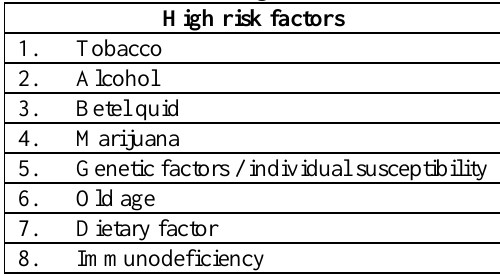
Table 1: High risk factors for oral